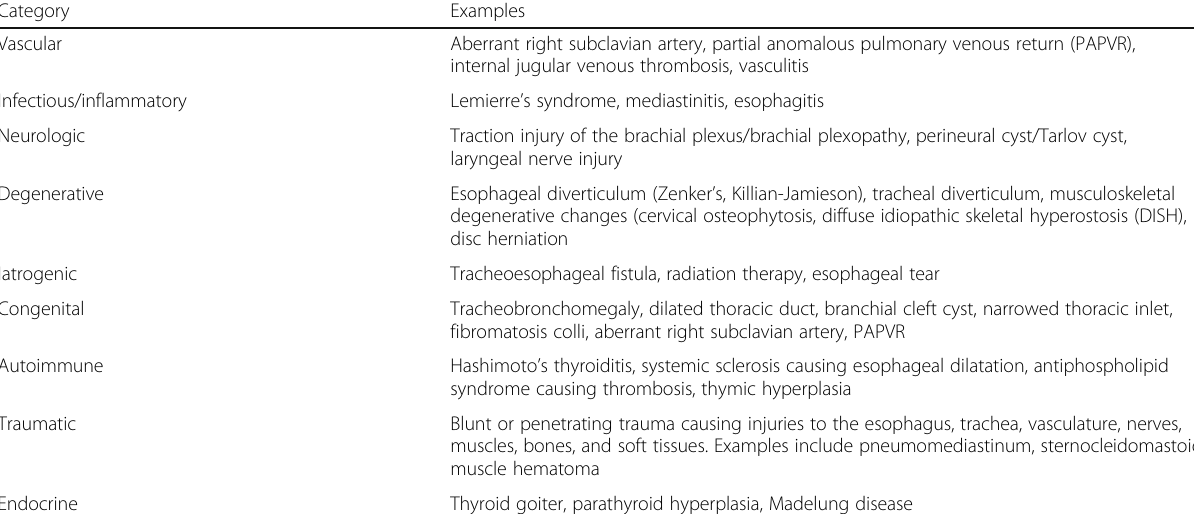
Table 1 Representative non-neoplastic pathology of the thoracic inlet based on the mnemonic “ VINDICATE ” Category